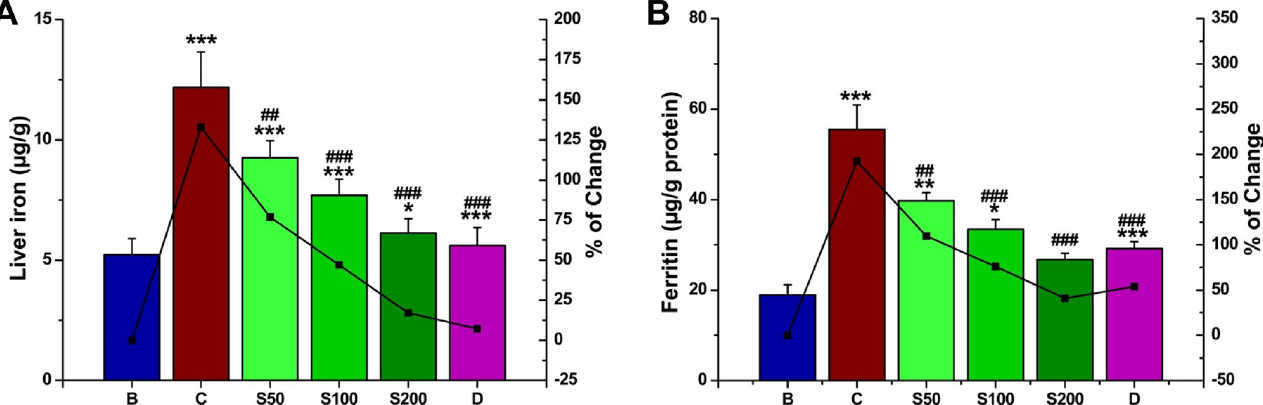
Fig 6. Effect of DBME on hepatic iron content and serum ferritin level. (A) hepatic iron content, (B) serum ferritin level. Mice were randomly divided into six groups (blank, B; control, C; 50 mg/kg b.w. DBME, S50; 100 mg/kg b.w. DBME, S100; 200 mg/kg b.w. DBME, S200; desirox group, D) and treated as described in ‘ experimental design ’ section. Values are expressed as mean ± SD of six mice. * p < 0.05, ** p < 0.01, *** p < 0.001 compared with blank and ##p < 0.01, ###p < 0.001 compared with control.